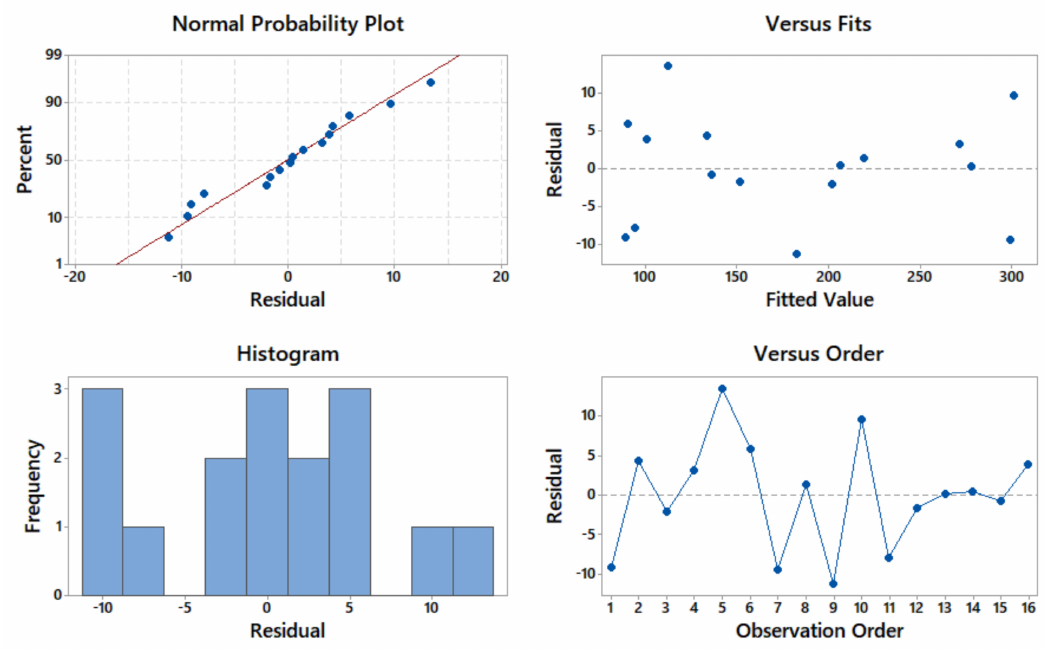
Figure 10. Residual plot of the cutting force F z